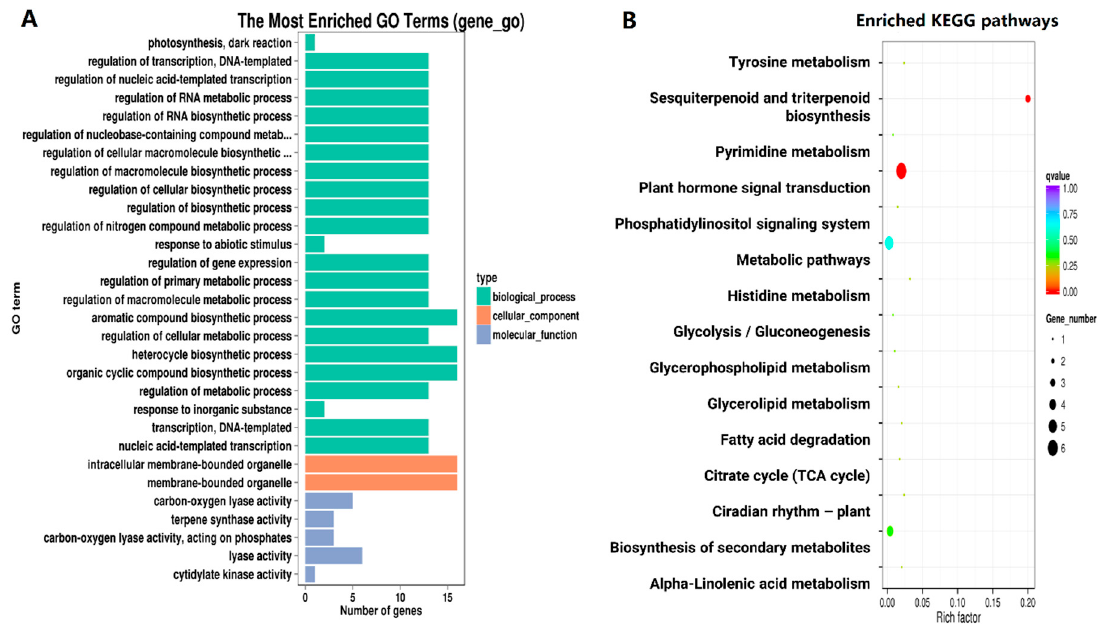
Figure 4. Gene Ontology (GO) and the Kyoto Encyclopedia of Genes and Genomes (KEGG) analysis of common DEGs in the process of premature senescence. ( A ) Barplot of significantly enriched GO terms. The x -axis represents the number of genes belonging to the left GO terms. The y -axis indicates GO terms. ( B ) Enriched KEGG pathways. Rich factor represents the ratio of the number of enriched DEGs in the KEGG pathway and the number of annotated background genes in this pathway. The x -axis shows rich factor of each pathway. The y -axis refers to KEGG pathways.